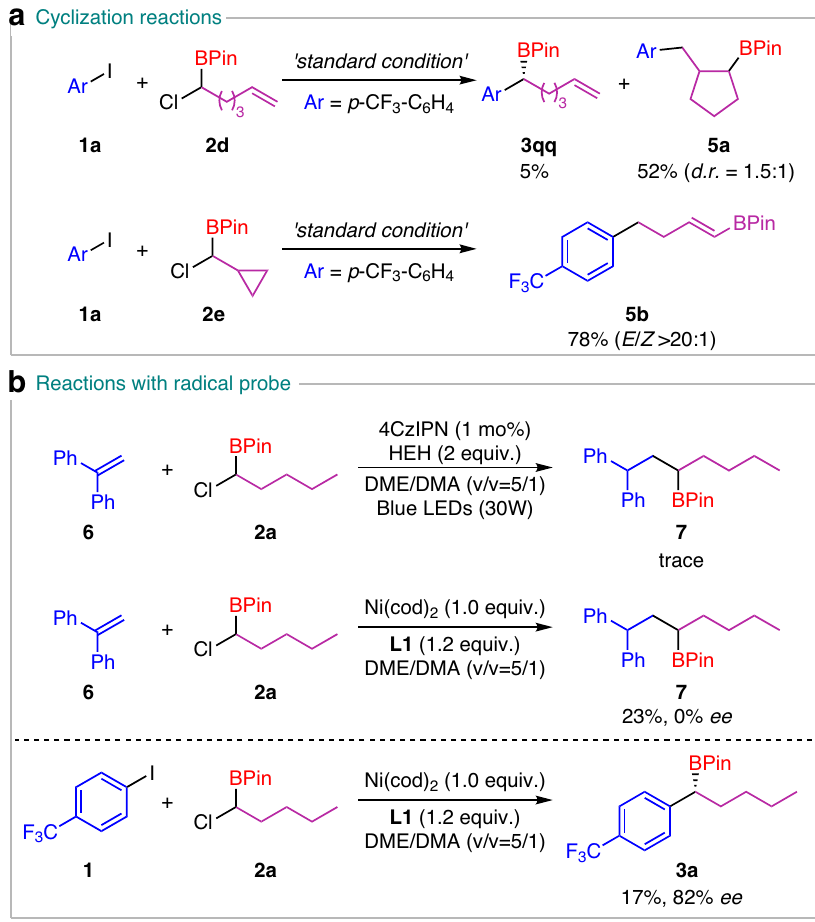
Fig. 5 Mechanistic studies. a Cyclization reactions. b Reactions with radical probe.